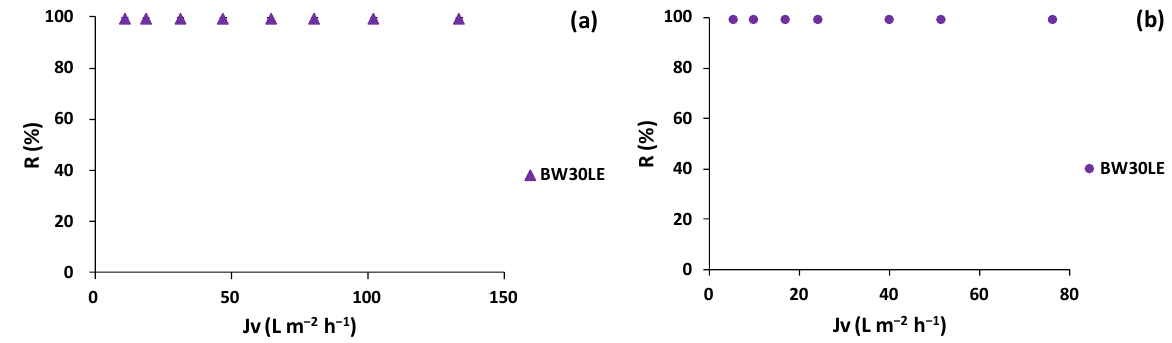
Figure 7. Polyphenol rejection variation as a function of the trans-membrane flux for BW30LE RO membrane for ( a ) lees filters and ( b ) olive pomace extracts.